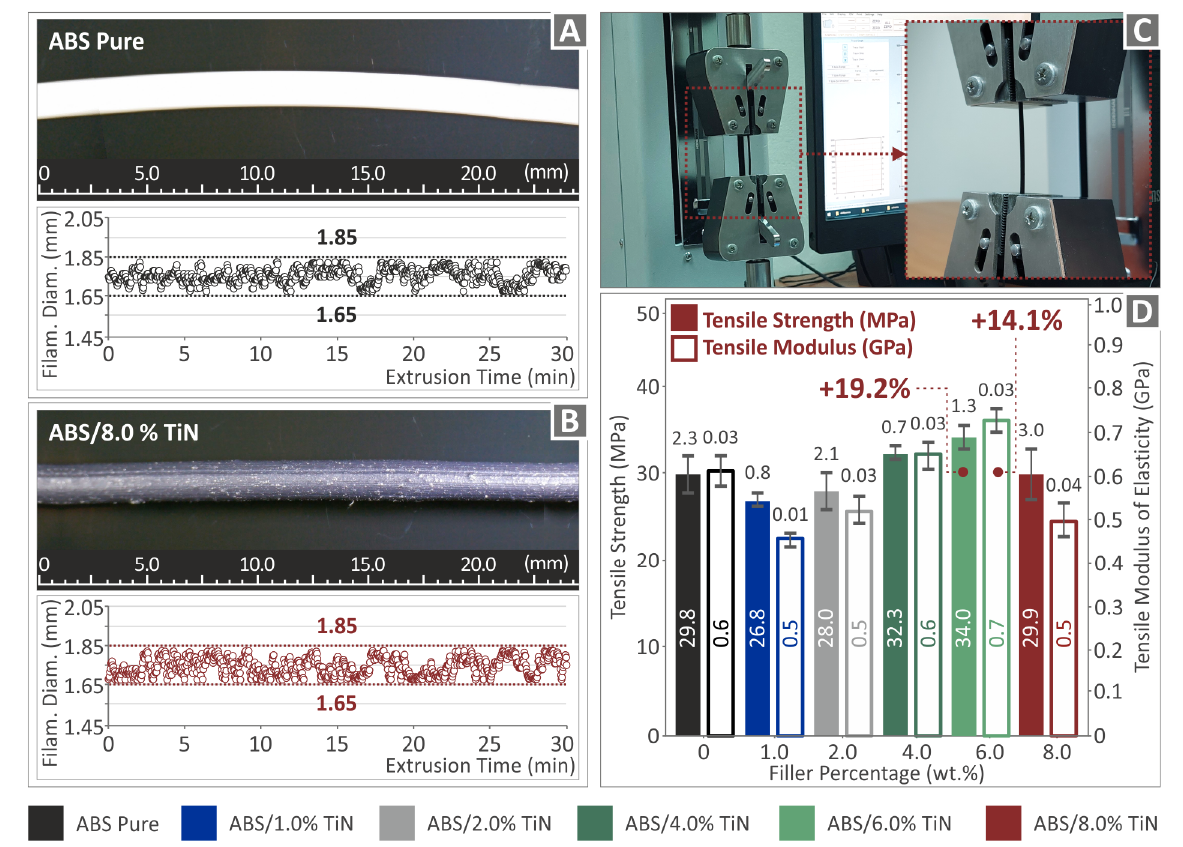
Figure 7. Real-time image and diameter measurements of the filament segment produced by the extrusion process for ( A ) pure ABS and ( B ) ABS/TiN 8.0 wt. % nanocomposite ( C ) experimental setup for the tensile test measurements and ( D ) results for the tensile strength and the tensile modulus of elasticity of the produced filaments.